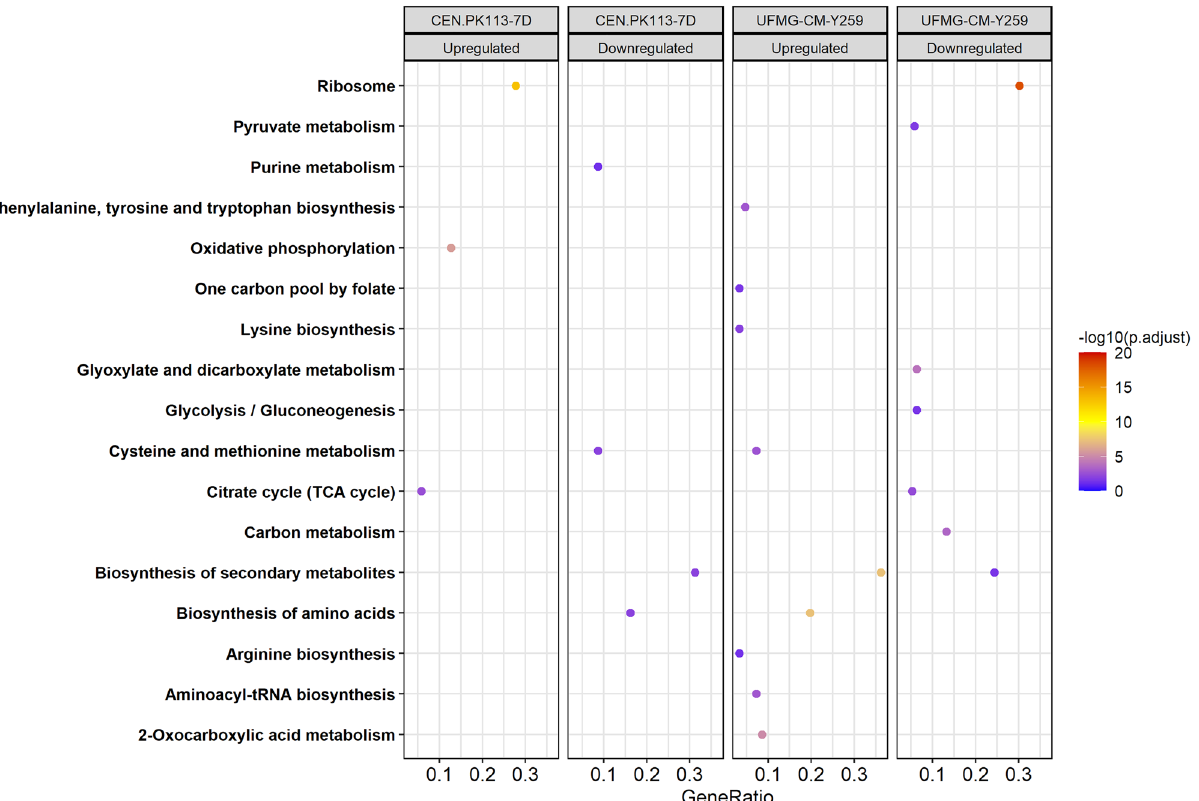
Figure 3. Pathway enrichment analysis for statistically significant proteins with an adjusted p value < 0.05 for S. cerevisiae strains CEN.PK113-7D and UFMG-CM-Y259 grown on sucrose compared to glucose grown cells. For JP1 no significant enrichments were detected. KEGG annotation was used for mapping the pathways. GeneRatio represents the proportion of proteins (gene products) in the correspondent abundance groups that is found in each category.